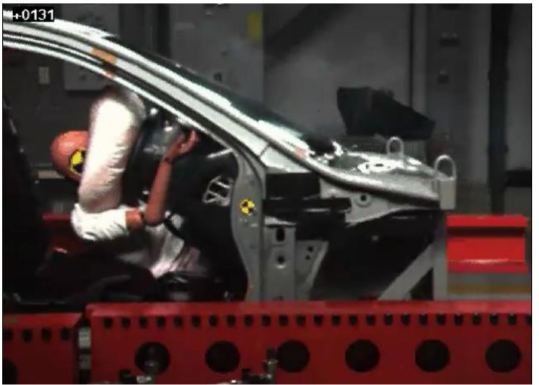
Figure 5. Instant at which the entire dummy’s torso slid under the instrument panel in test 3.